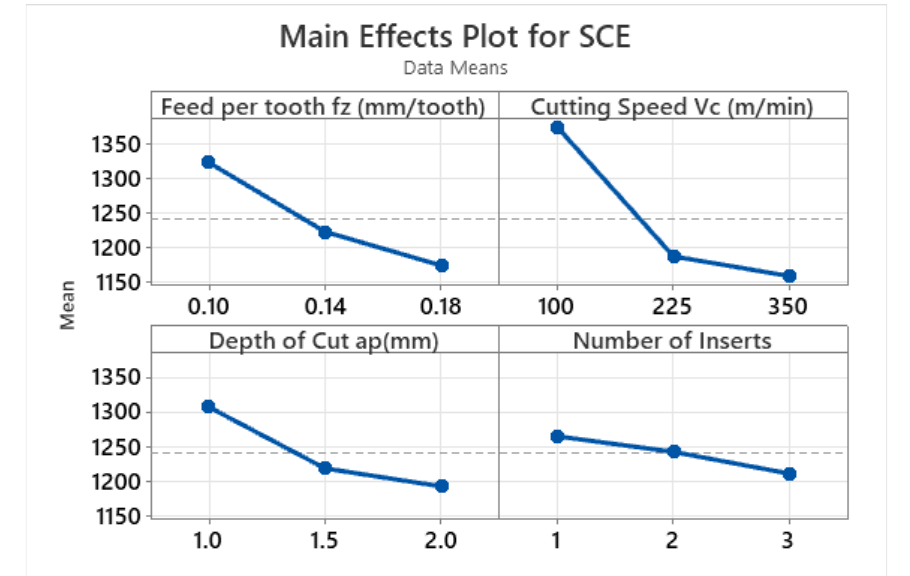
Figure 3. Main effect plots for specific cutting energy (J/cm 3 ). Table 6. ANOVA results for specific cutting